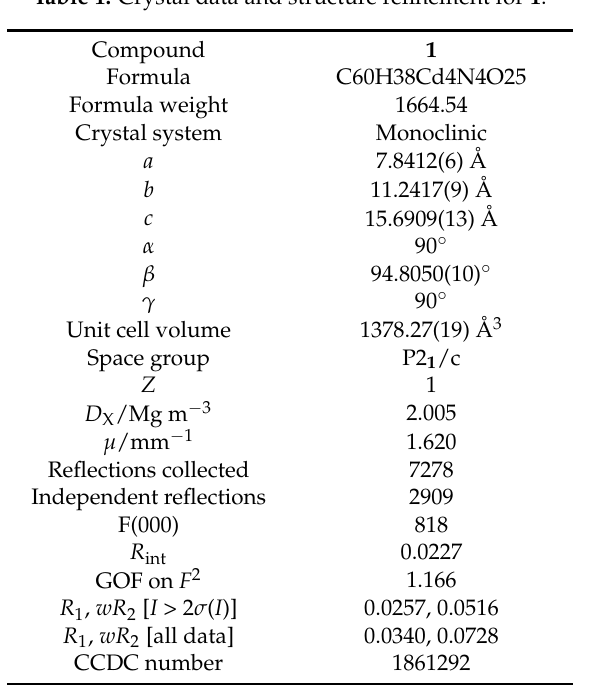
Table 1. Crystal data and structure refinement for 1 .